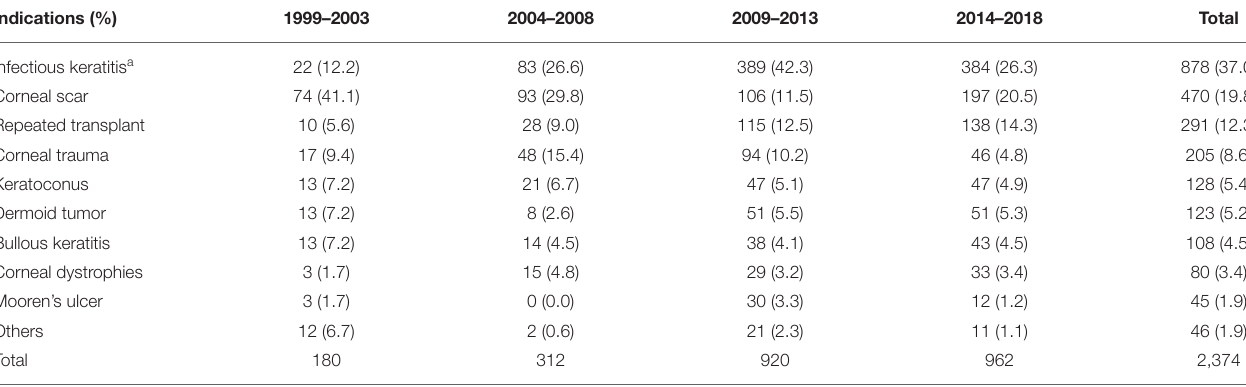
TABLE 2 | Indications for corneal